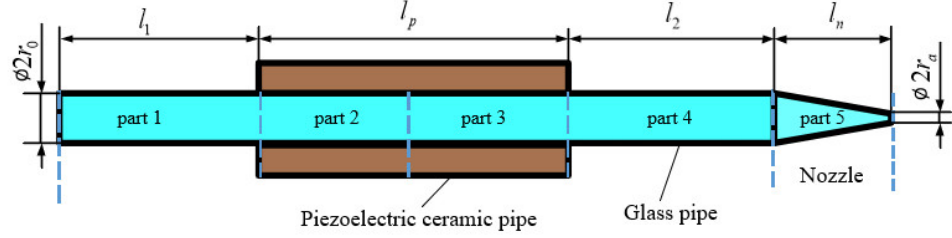
Figure 1. Structure and layout of the printhead.